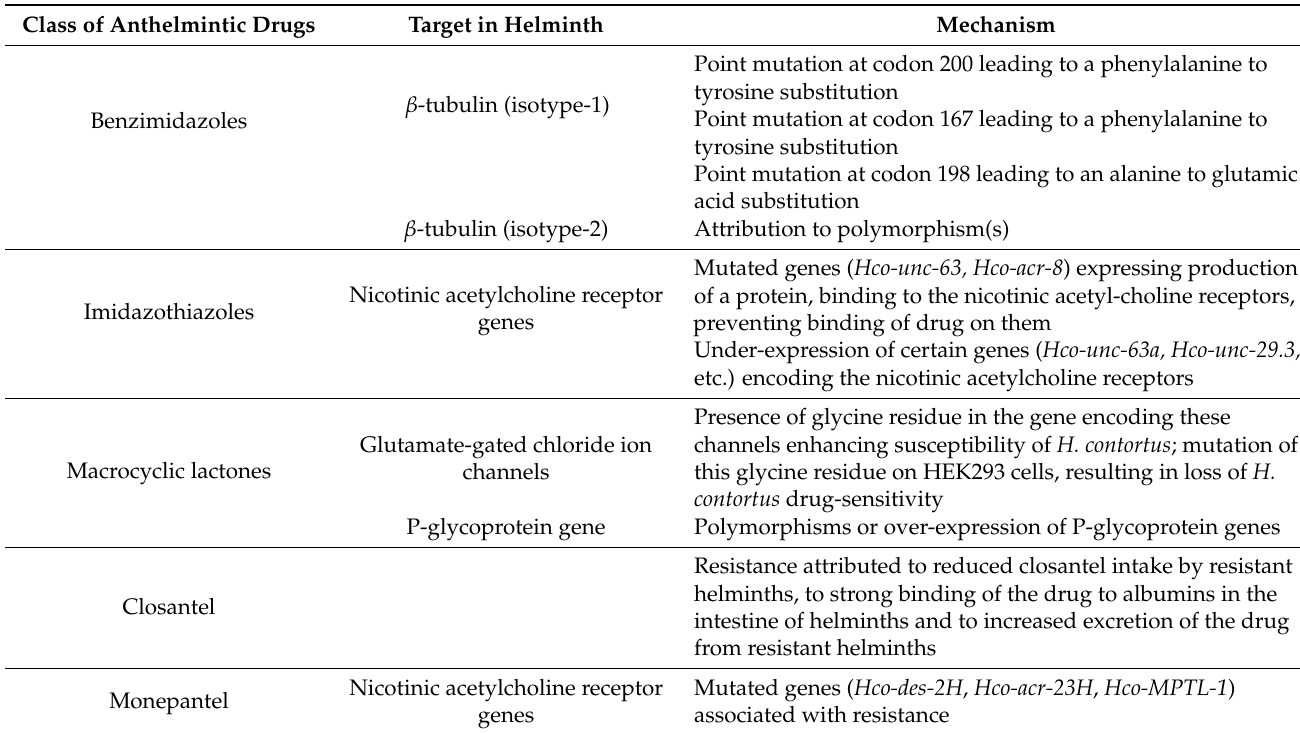
Table 2. Summary of mechanisms for the resistance of H. contortus against the various anthelmintic drugs. Class of Anthelmintic Drugs Target in